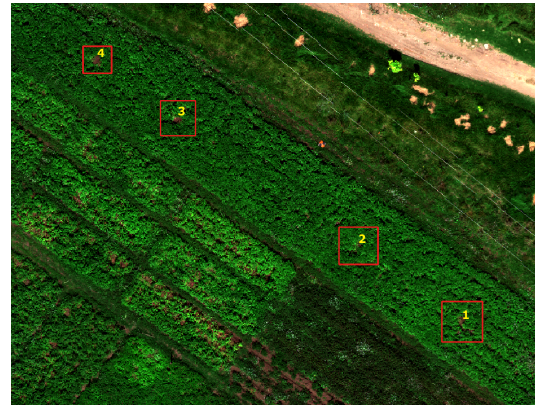
Table 2. GCPs RMSE - Flight 1 - 28/12/2019 12:10PM Table 3. CPs RMSE - Flight 1 - 28/12/2019